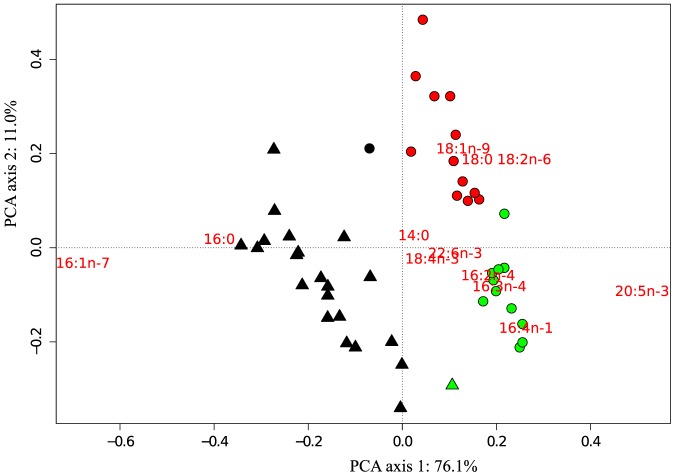
Principal component plot of fatty acid proportions (arcsin square root transformed) of C. centralis and ice algae.Colours correspond to the clusters identified in Fig. 4; black indicates cluster 1, red is cluster 2 and green is cluster 3. Fatty acid vectors are scaled proportional to eigenvalues while samples are unscaled.